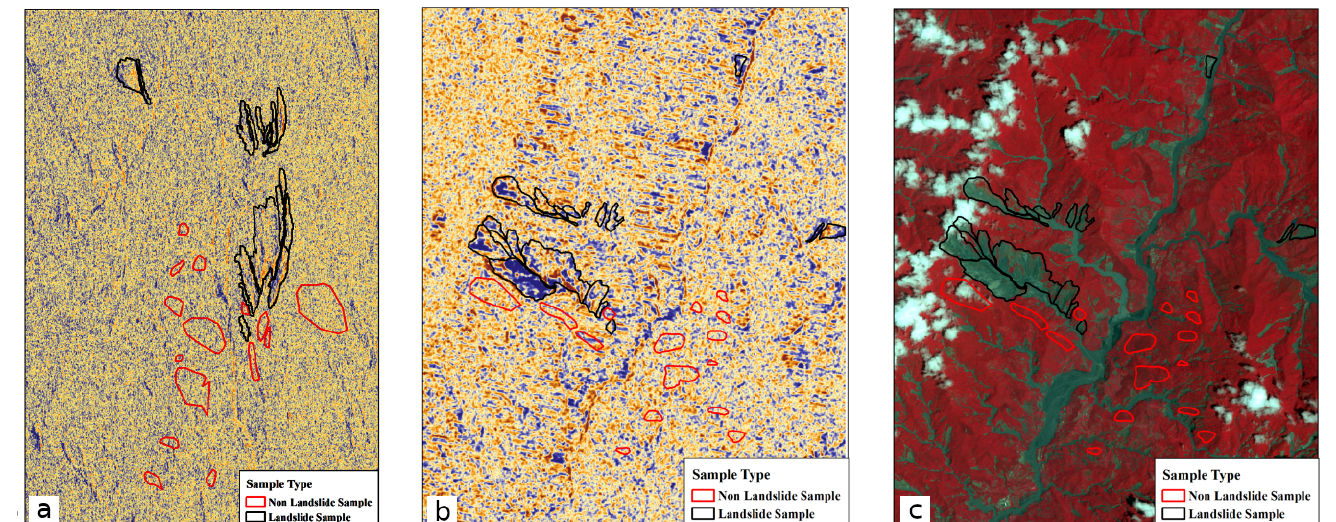
Figure 7. LR index images with pixel sample areas for identifying a feasible index to distinguish objects that were collected from 18 landslide regions (black outlines) and 15 nonlandslide regions (red outlines). Base images are the LR index image in slant-range ( a ), LR index image in ground-range ( b ), and a SPOT-5 image acquired during the same period ( c ).